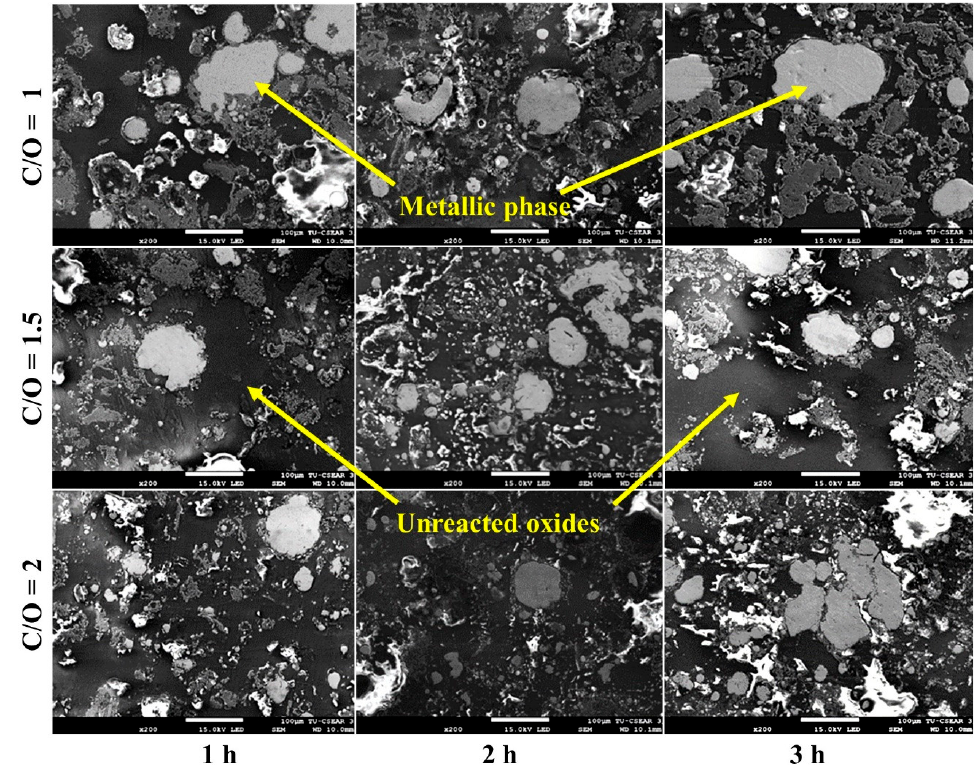
Figure 3. SEM micrograph of cross-sectioned pellets after heating at 1550 °C for up to 3 h. Figures 4–6 show XRD spectra of the pellets with C/O ratios of 1, 1.5, and 2 after